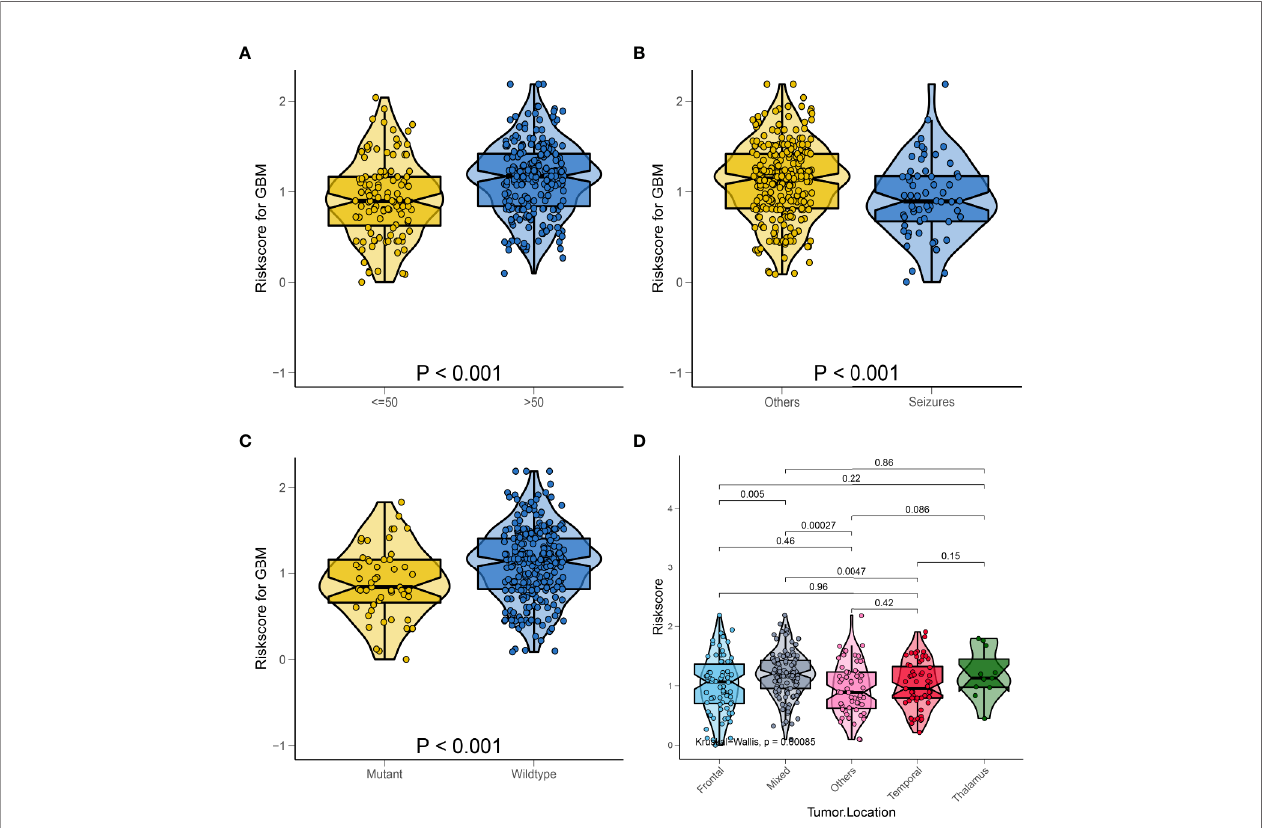
FIGURE 5 | Relationship between HRS and some clinical characteristics in the whole data. (A) Box violin plot of HRS values of patients in age <= 50 years old group and age > 50 years old group; (B) Box violin plot of HRS values of patients in seizures group and others group; (C) Box violin plot of HRS values of patients in IDH mutant group and IDH wild-type group; (D) Box violin plot of HRS values of patients with tumor in frontal group, mixed group, others group, temporal group and thalamus